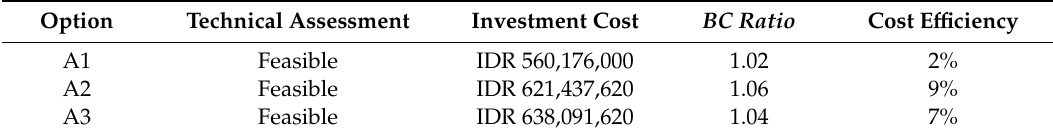
Table 7. Result of technical and economic